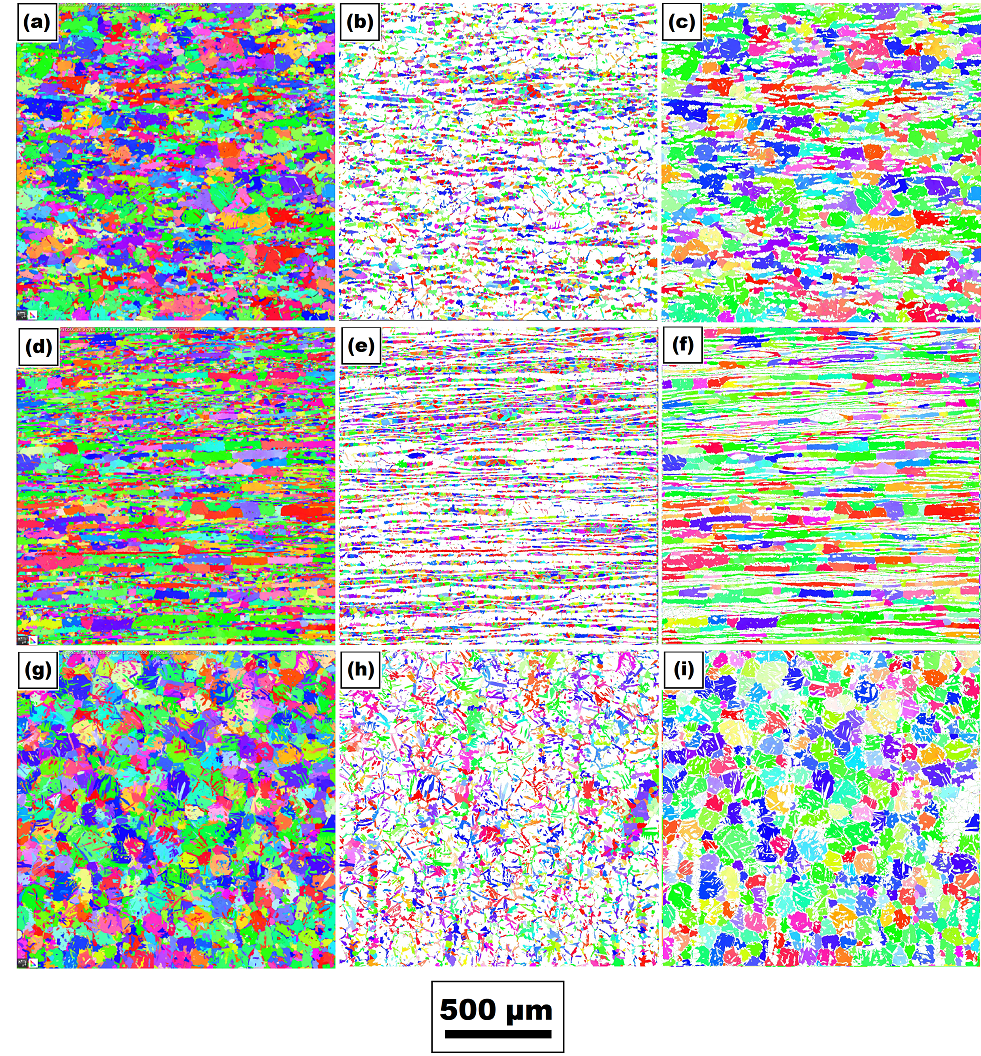
Figure 8. Illustration of grains in the area achieving the maximal temperature of 1386 ◦ C: in x -axis (PD)—( a ) overall image of grains; ( b ) austenite grain; and ( c ) ferrite grain; in y -axis (PD)—( d ) overall image of grains; ( e ) austenite grain; and ( f ) ferrite grain; in z -axis (PD)—( g ) overall image of grains; ( h ) austenite grain; and ( i ) ferrite grain. Table 4. Grain size of ferrite and austenite in the basic material and in the area achieving the maximal temperature of 1386 ◦ C. x